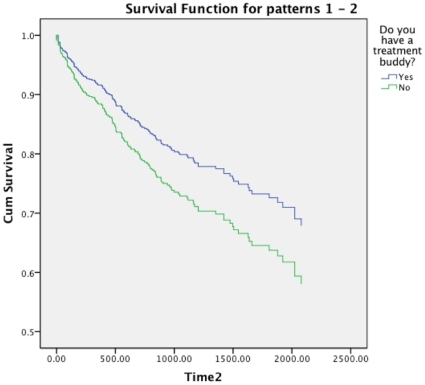
Survival function (days) for patients according to Treatment buddy.